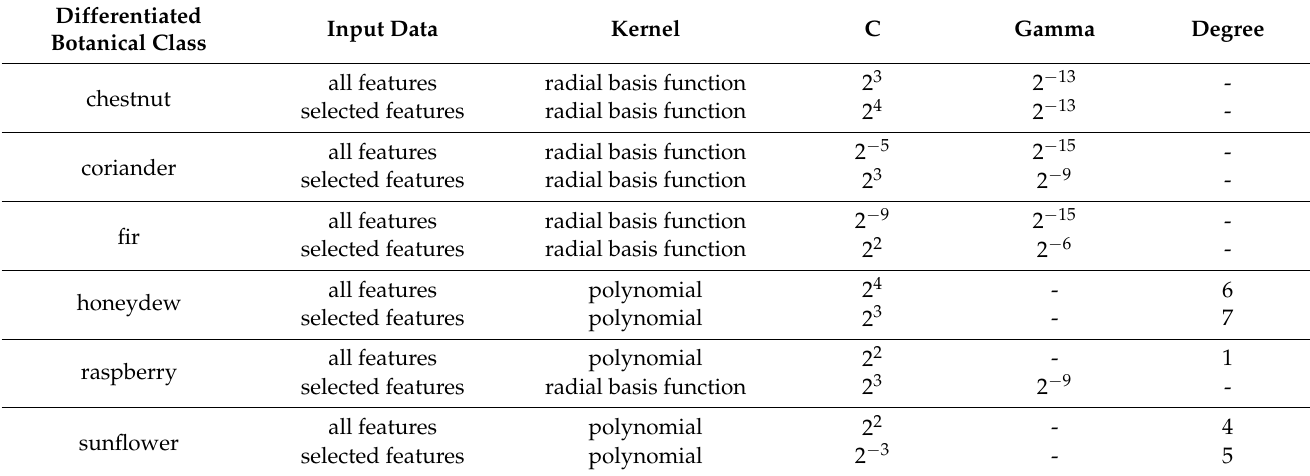
Table 1. Configuration of the developed support vector machines models for each honey